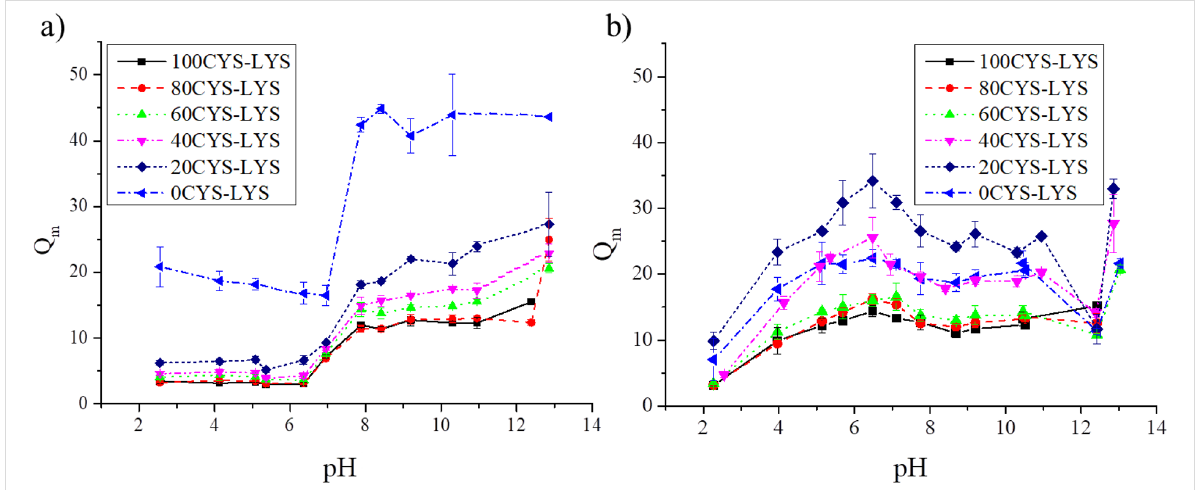
Figure 2: The dependence of the mass swelling degree of (a) the PSI- and (b) the PASP-based gels on the pH value.